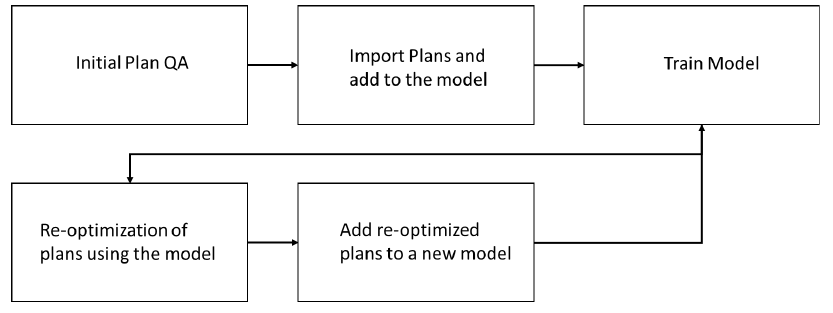
Figure 1. Workflow chart for model training.